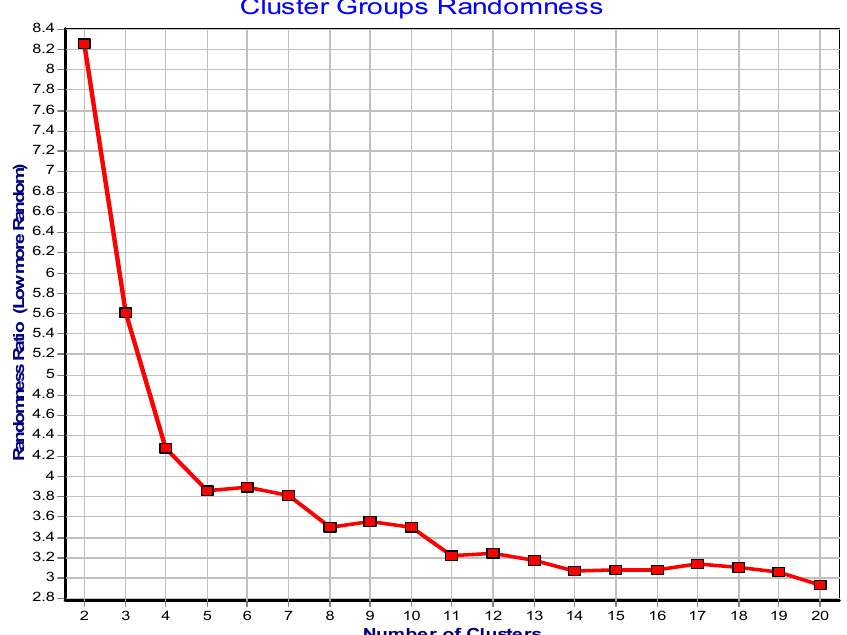
Figure 9. Cluster groups randomness of Zamzama Gas Field.